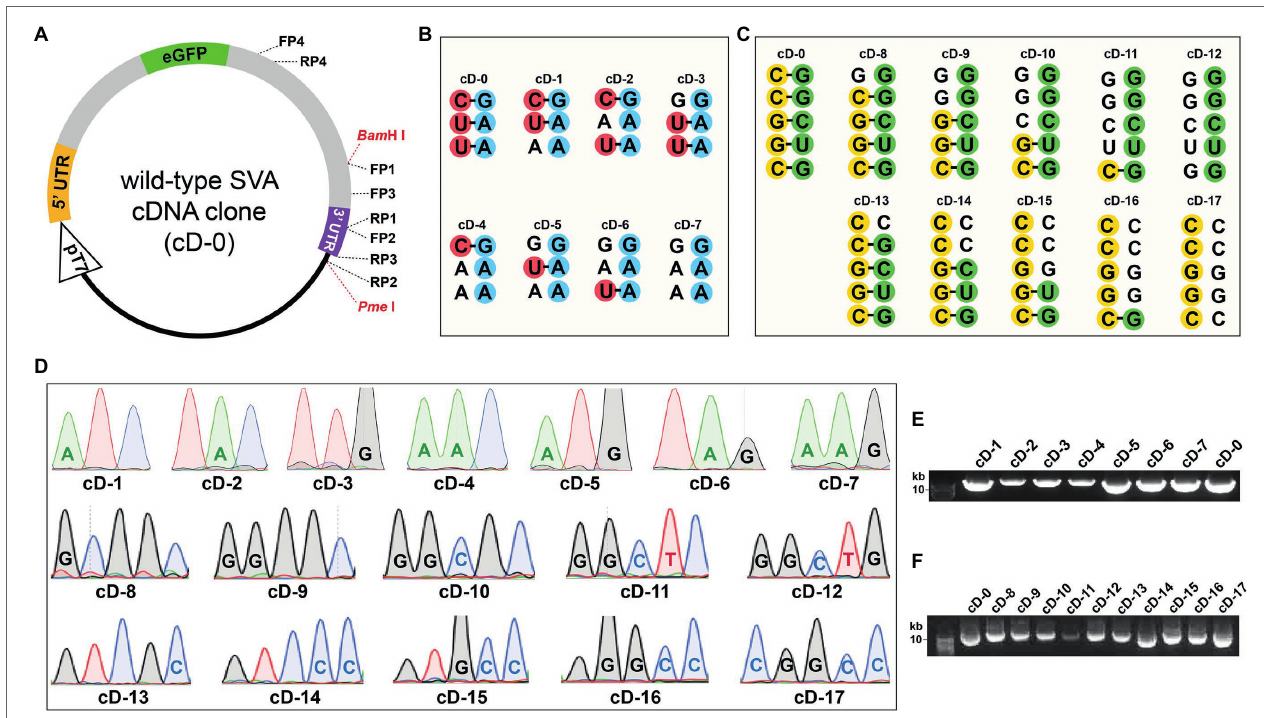
FIGURE 2 | Construction of 17 full-length SVA cDNA clones. Schematic representation of eGFP-tagged SVA cDNA clone without mutation (A) . Dotted lines indicate FP1/RP1-, FP2/RP2-, FP3/RP3-, FP4/RP4-, and Bam H I/ Pme I-targeted sites. The proportion of elements does not exactly match them in the cD-0 plasmid. Wild-type and mutated KLFMs (B) . Mutated sites are unmarked with red/blue circles. Wild-type and mutated PFMs (C) . Mutated sites are unmarked with yellow/green circles. Sanger sequencing chromatograms of 17 cDNA clones (D) . Mutated sites are marked with letters inside their sequencing peaks. Agarose gel electrophoresis of cD-1 to − 17 after plasmid purification (E,F)